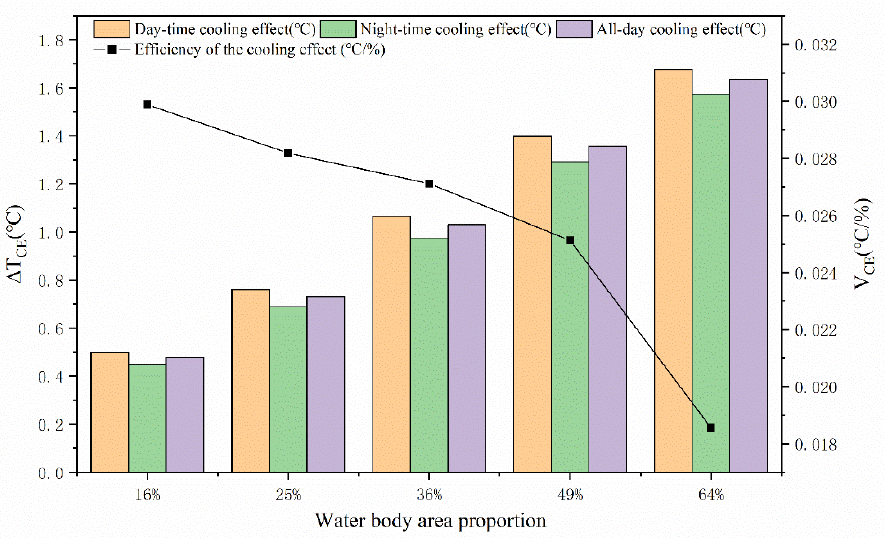
Figure 3. Cooling effect and efficiency of the cooling effect for different water body area proportions.